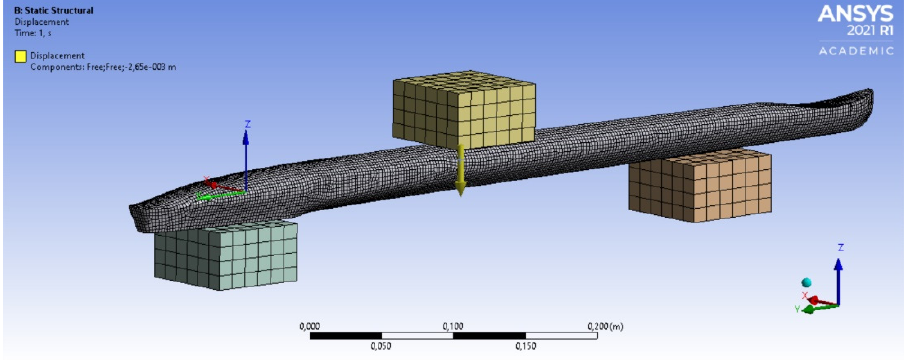
Figure 11. Boundary conditions from the flexural tests .